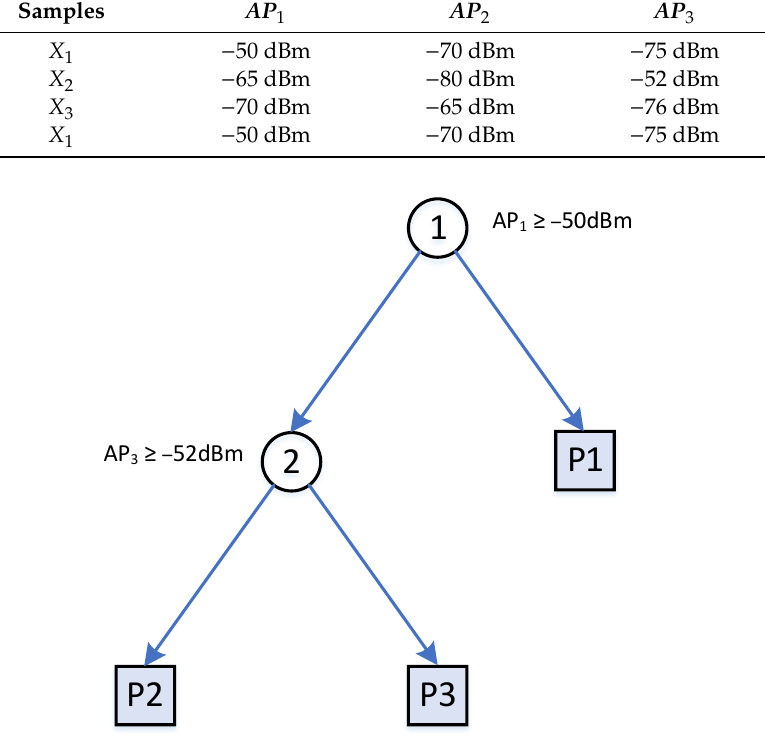
Figure 1. A decision tree with two internal and three leaf nodes for splitting 𝑋 1 , 𝑋 2 , 𝑋 3 in Table 1.